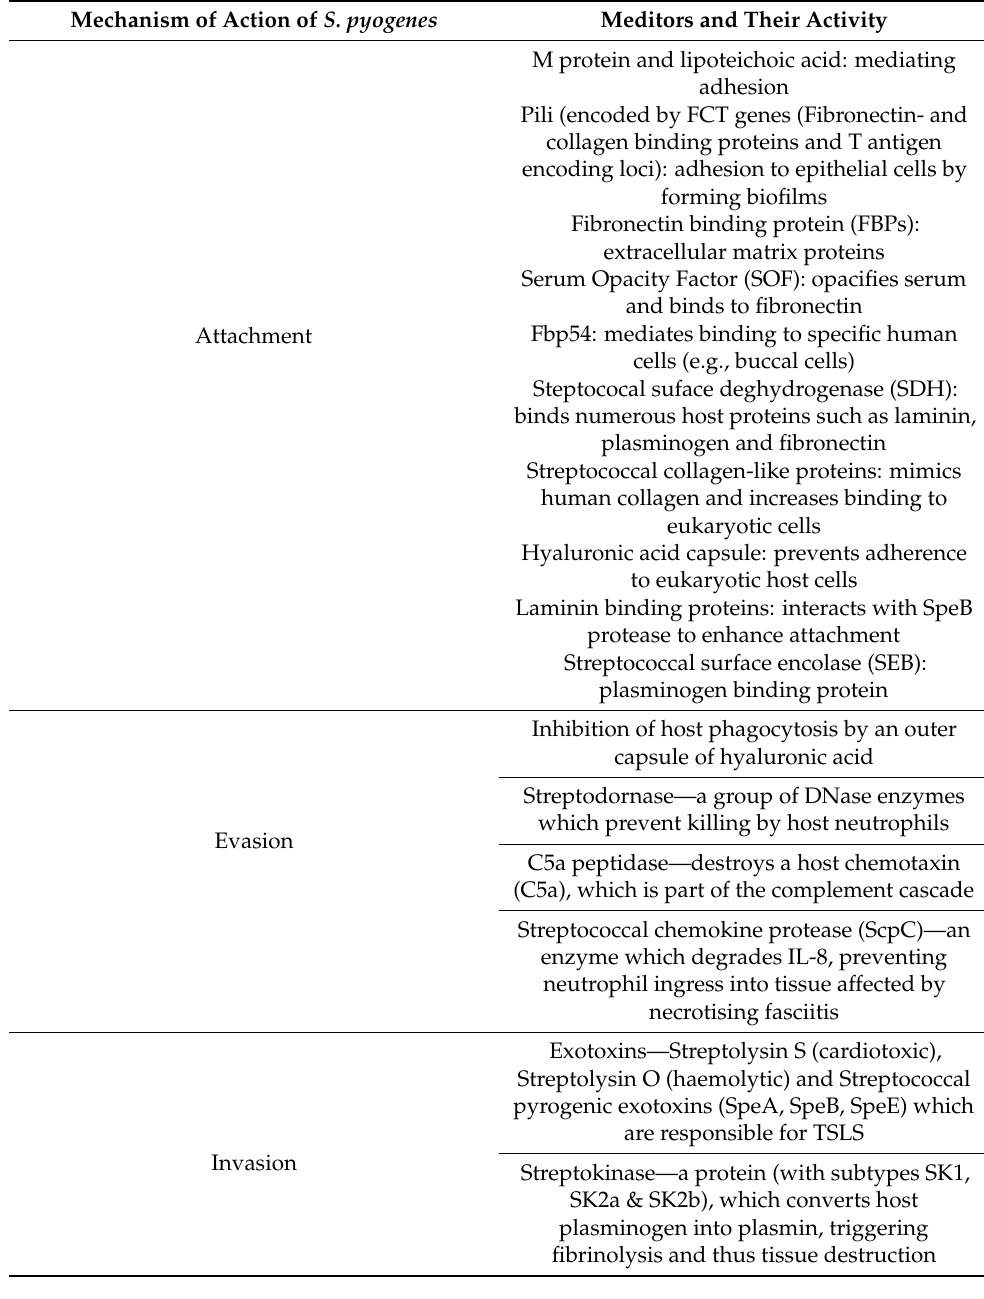
Table 1. GAS virulence